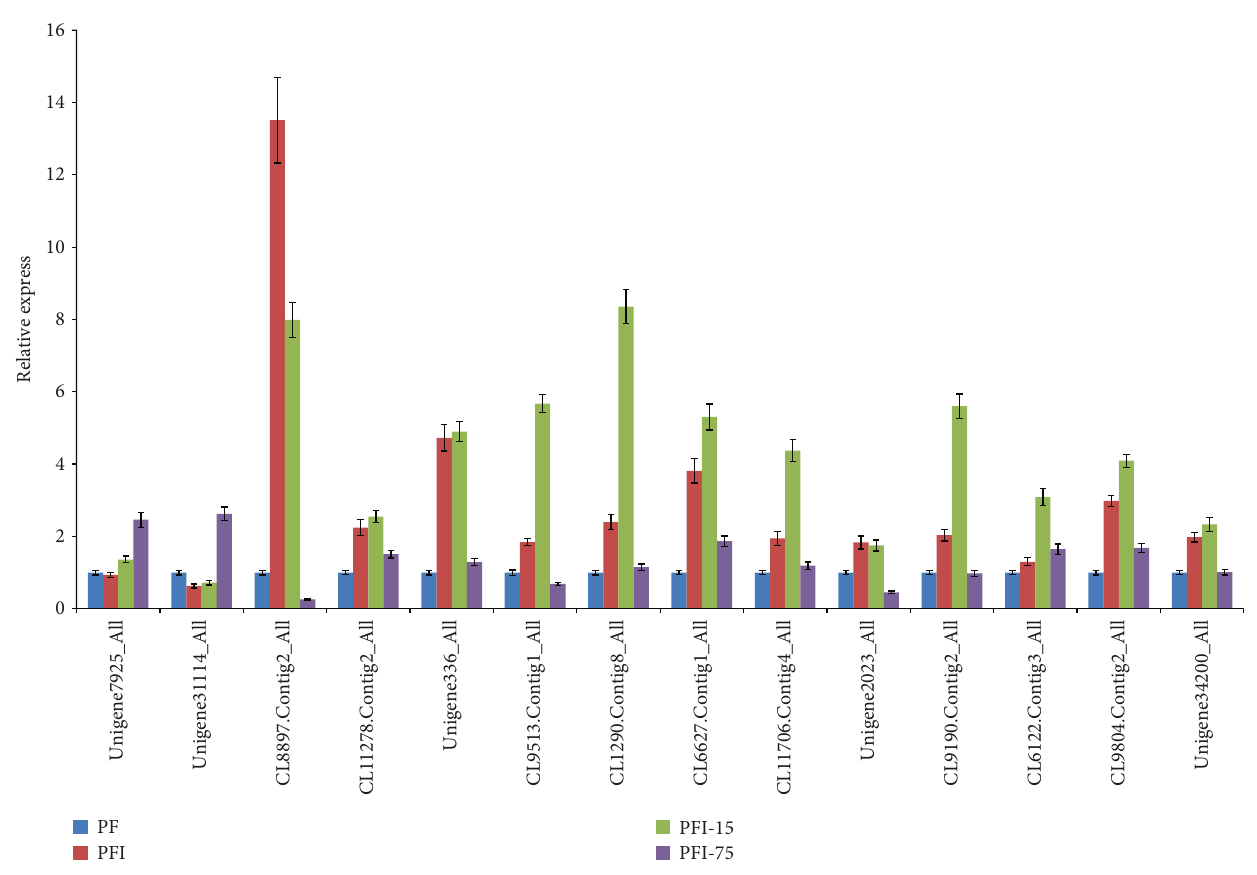
Figure 5: Relative expression levels of the mRNA in P. fortunei by qRT-PCR. PF: healthy P. fortunei . Unigene7925_All: cytosolic NADP- malic enzyme; Unigene31114_All: ribulose-1, 5-bisphosphate carboxylase/oxygenase; CL8897.Contig2_All: germin-like protein; CL11278.Contig2_All: ATP synthase; Unigene336_All: anganese superoxide dismutase; CL9513.Contig1_All: chloroplast pigment-binding protein CP29; CL1290.Contig8_All: auxin-induced protein PCNT115-like; CL6627.Contig1_All: mitochondrial NAD-dependent malate dehydrogenase; CL11706.Contig4_All: peptidyl-prolyl cis-trans isomerase; Unigene2023_All: fasciclin-like arabinogalactan protein 10-like; CL9190.Contig2_All: chlorophyll a-b binding protein; CL6122.Contig3_All: ATP-dependent zinc metalloprotease FTSH 2; CL9804.Contig2_All: V-type proton ATPase subunit B2 OS= Arabidopsis thaliana ; Unigene34200_All: UDP-glucose pyrophosphorylase. The 18S rRNA was acted as an internal reference gene for normalization. The normalized mRNA transcript levels were arbitrarily set to 1 in PF. Standard errors of the mean are represented by the error